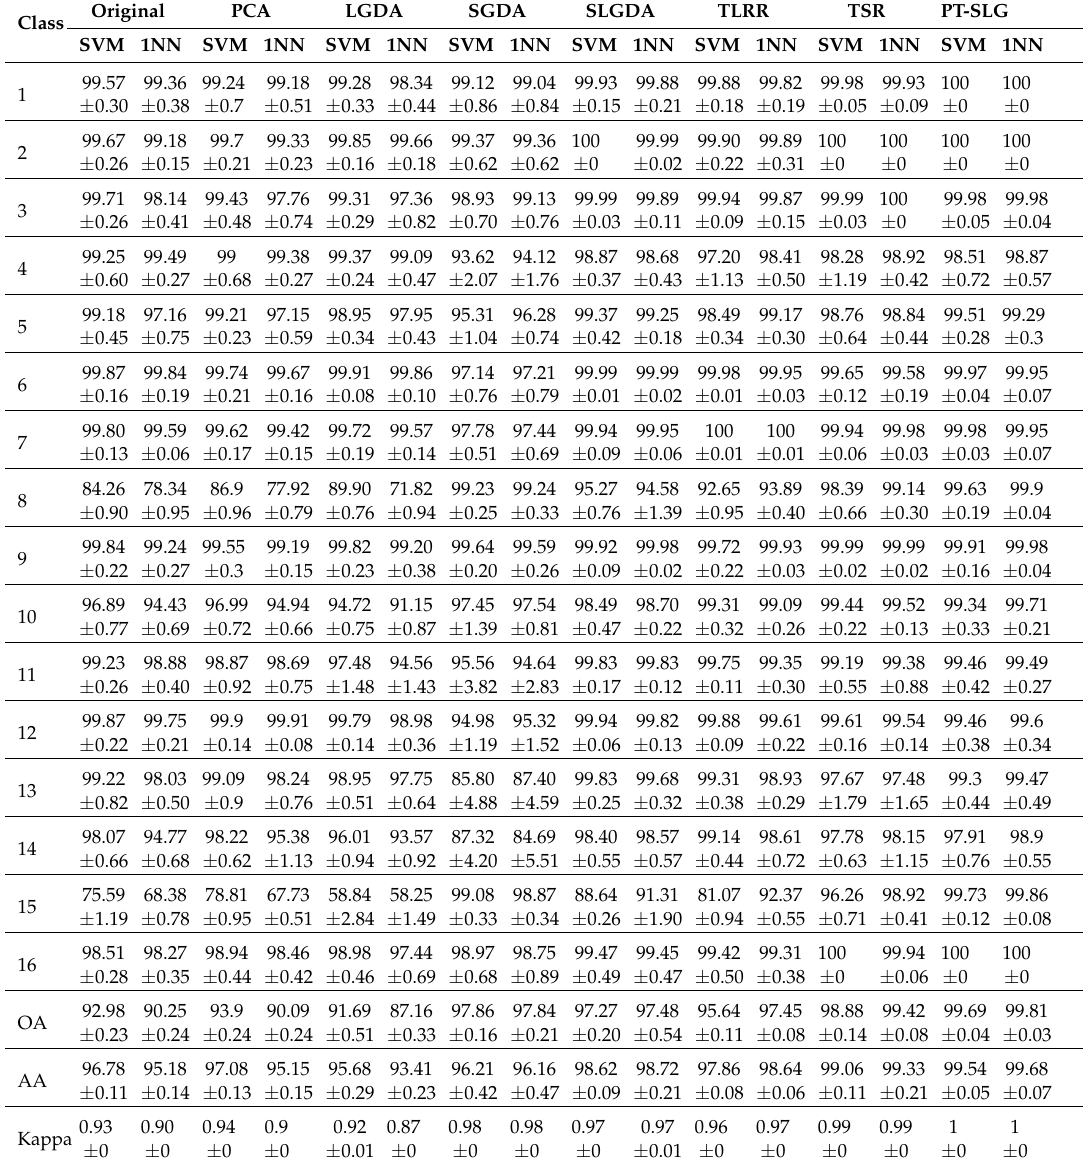
Table 3. Classification results on Salinas dataset (reduction dimensionality =